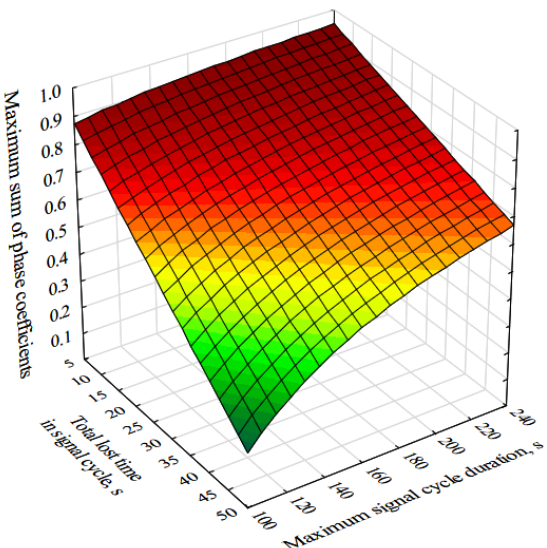
Figure 7. The dependence of the maximum value of the sum of phase coefficients on lost time and the maximum duration of the traffic signal cycle.